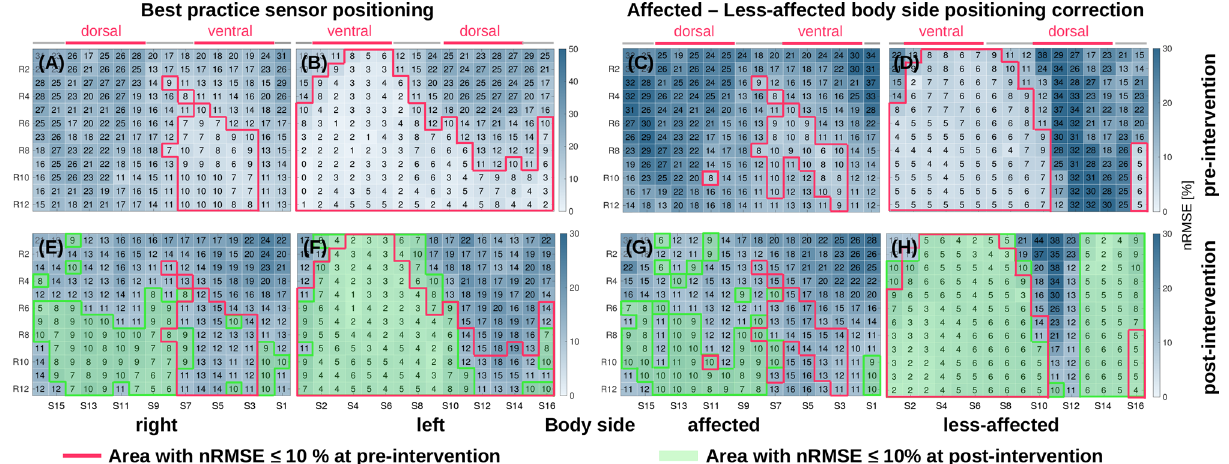
Figure 8. Average estimation error of stride duration depending on sensor position across all eight hemiparetic patients derived for pre- and post-intervention. ( A , B , E , F ) nRMSE maps for left/right upper leg region sensor placement, ignoring the impaired body side. ( C , D , G , H ) nRMSE maps when correcting for affected and less- affected body sides.